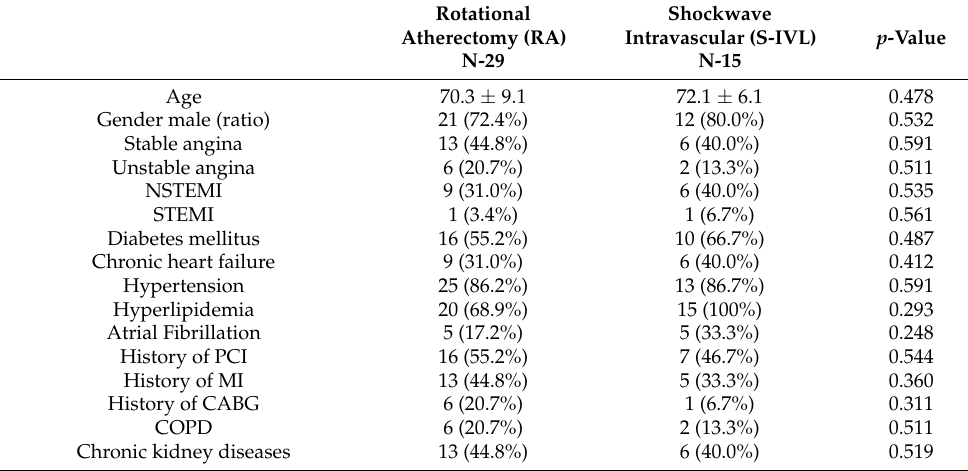
Figure 2. Exemplary PCI procedures. S-IVL-related procedure ( A – E ). ( A ) Distal LM significant stenosis; ( B ) non-compliant 3.5 mm balloon under-expansion; ( C ) S-IVL 3.5 mm balloon inflation; ( D ) stenting with DES 4. 0 mm; and ( E ) final post PCI angiogram. RA-related procedure ( F – L ). ( F ) Distal LM critical stenosis with severe calcifications; ( G ) RA with burr 1.75 mm; ( H ) predilatation of LM with 3.5 mm non-compliant balloon; ( I ) pre-stenting angiogram; ( J ) LM/LAD stenting with DES 4.0 × 20 mm; ( K ) LM/LAD/Cx kissing balloons with non-compliant 3.5 mm/3.0 mm balloons; and ( L ) final post-PCI angiogram. Table 1. The baseline clinical characteristics of both study groups.